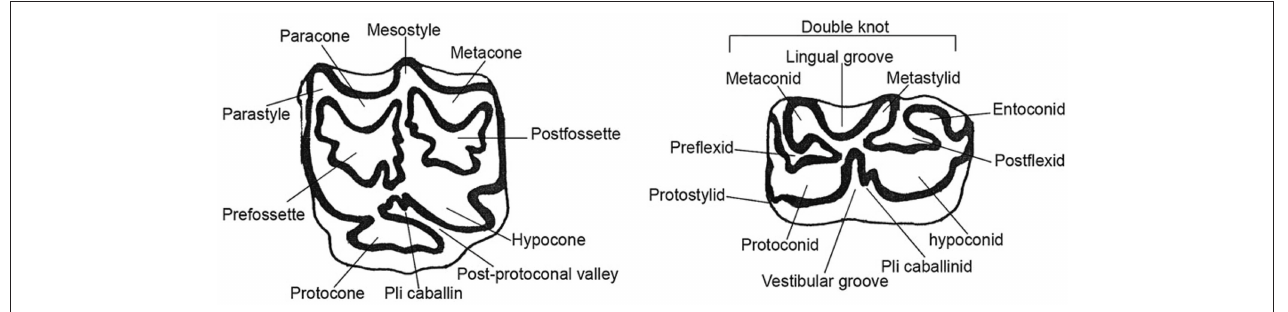
FIGURE 2 | Nomenclature used for upper and lower cheek teeth. Occlusal